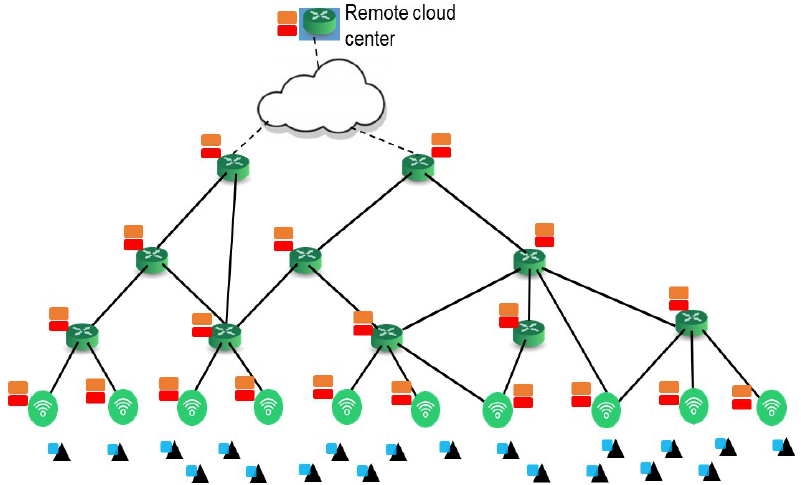
Figure 5. Typical tree-like designed network